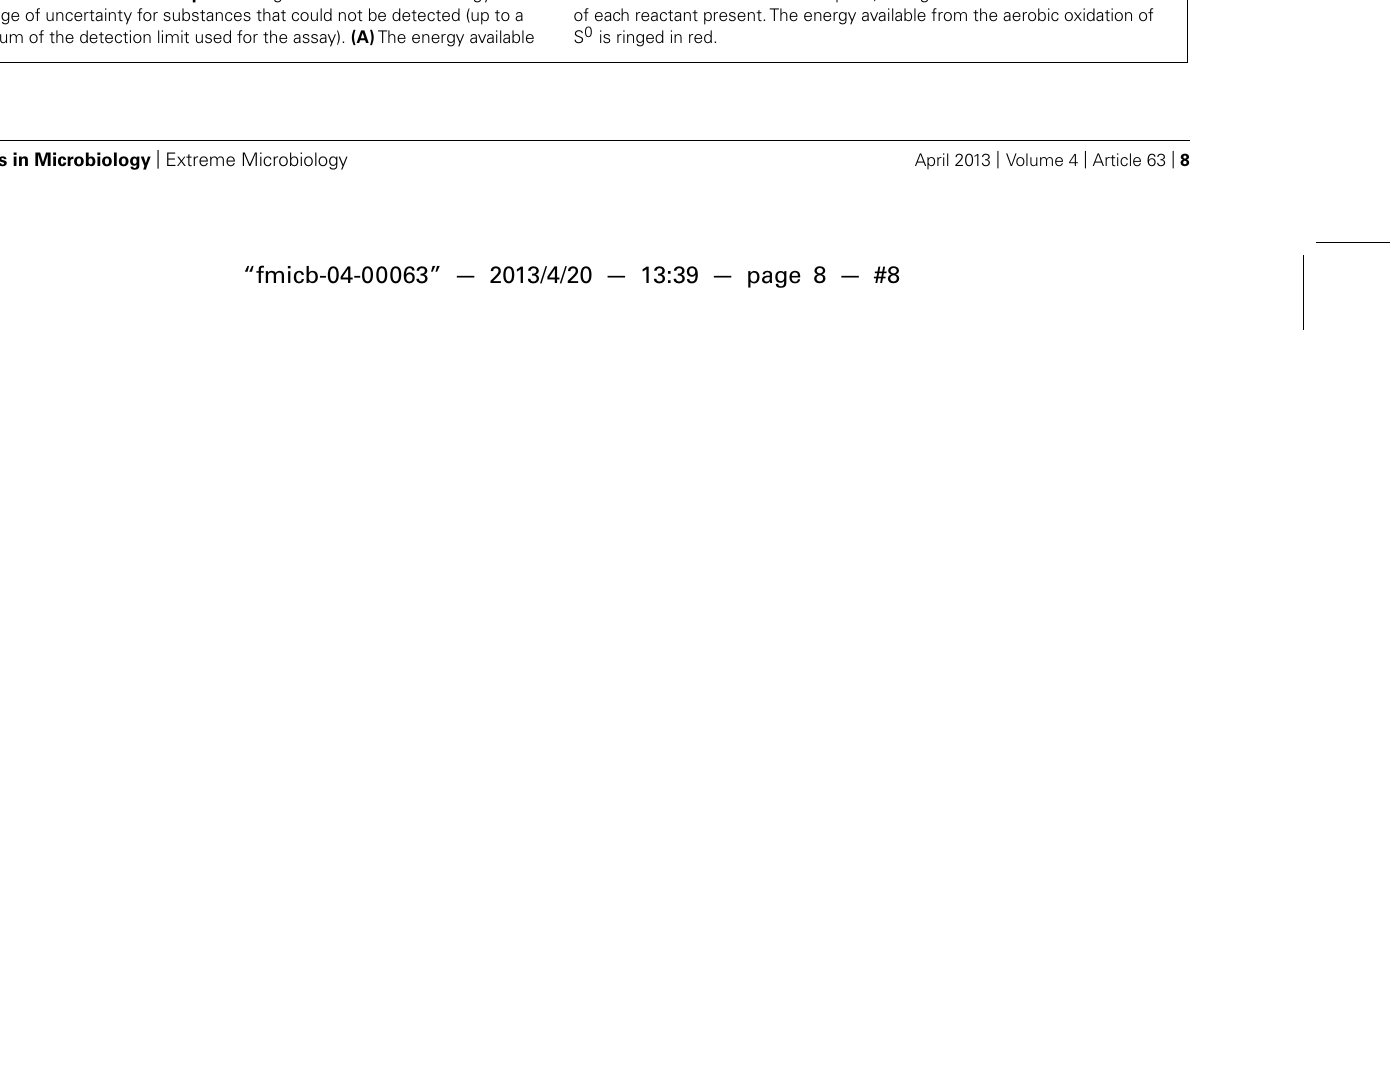
FIGURE 2 | Energy available from different redox reactions that could occur in the BF09-06 sulfur deposit. Ranges in the amount of energy reflect the range of uncertainty for substances that could not be detected (up to a maximum of the detection limit used for the assay). (A) The energy available